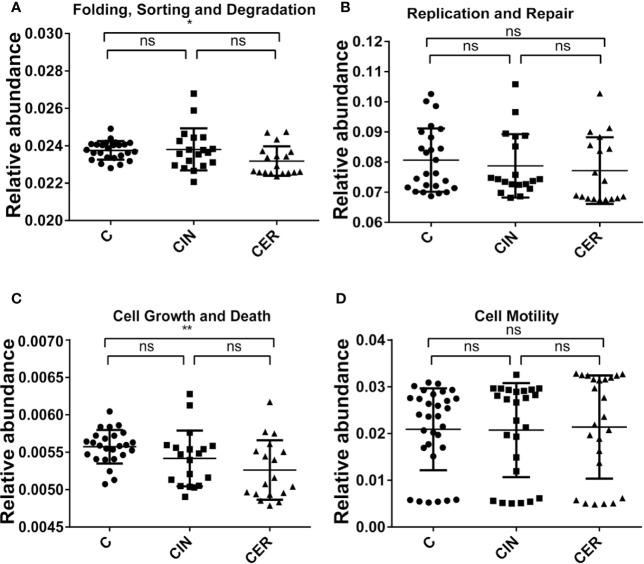
The difference in the construction of the vaginal flora at the level of phylum. The most abundant 20 phyla in each group (A), the differences among the main member (B), and the most common pathogens in the vaginal flora (C–E). C: Control group, a group of women who have no problem in gynecology. CER: Cervical cancer group, a group of women who were diagnosed a cervical cancer by pathological biopsy. CIN: Cervical intraepithelial neoplasis group, a group of women were diagnosed a by pathological biopsy or cytological test. * means p <0.05; ** means P <0.01; *** means P <0.001; p < 0.05 indicates significant difference. ns, no significance.